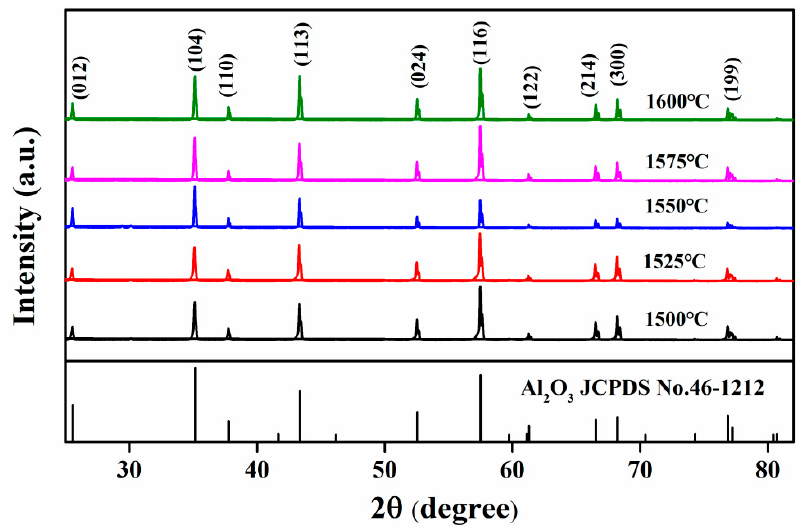
Figure 3. XRD patterns of Al 2 O 3 -G-M hot-pressed at different sintering temperature. Table 1. The relative density and mechanical properties of Al 2 O 3 -G-O and Al 2 O 3 -G-M prepared by the two feeding